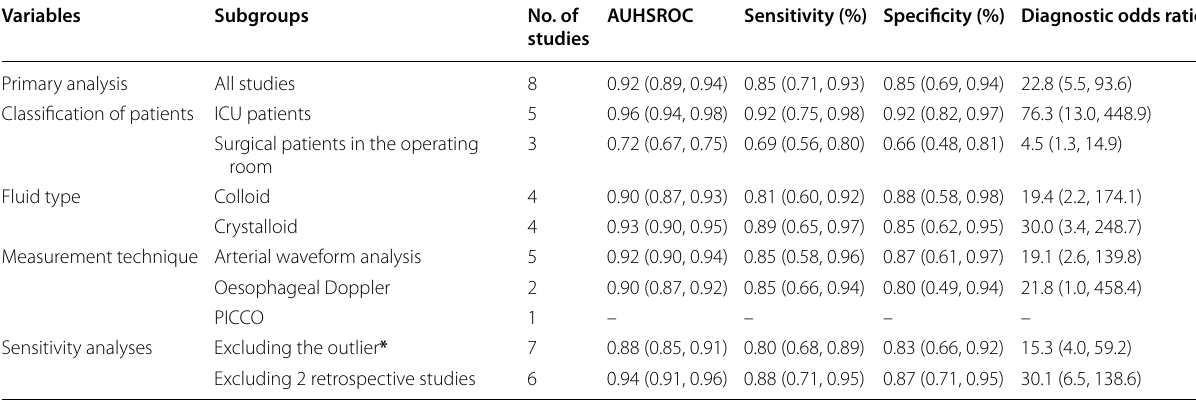
MAP mean arterial pressure, ICU intensive care unit, AUHSROC area under hierarchical summary receiver operating characteristic curve, PICCO pulse indicator continuous cardiac output * The study by Guarracino et al. was identified as the outlier based on a Galbraith plot